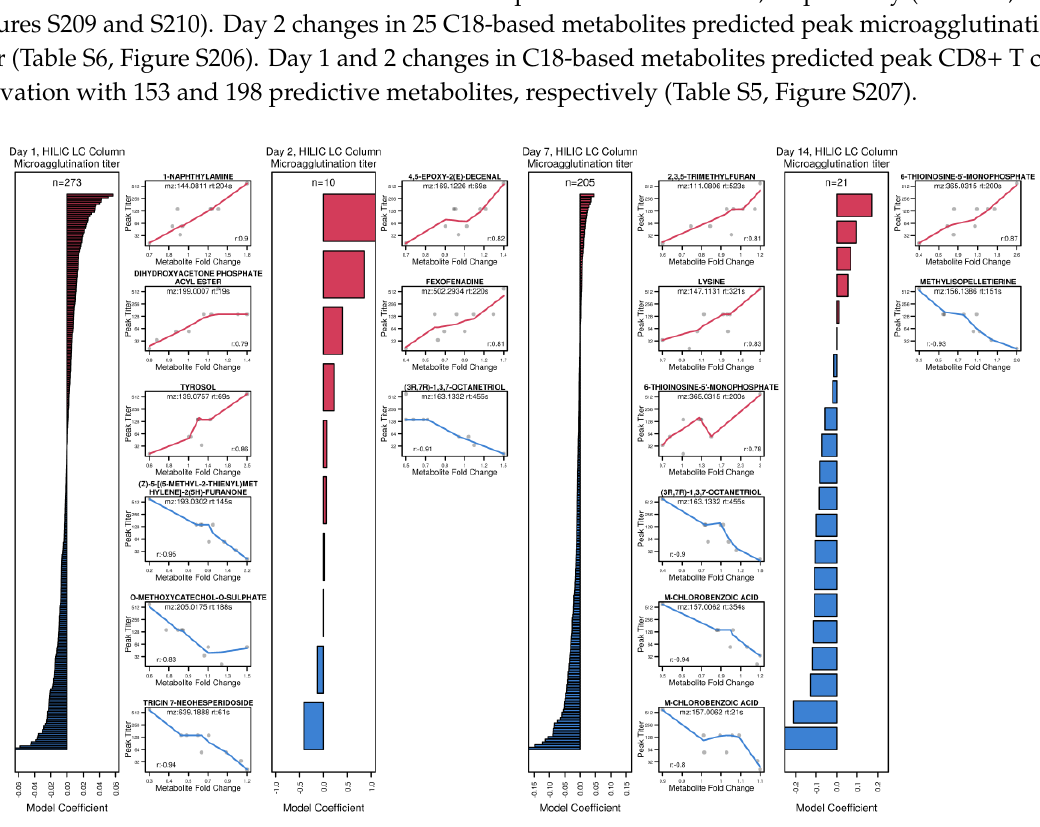
Figure 6. Metabolite changes on days 1, 2, 7 and 14 that best predicted peak microagglutination